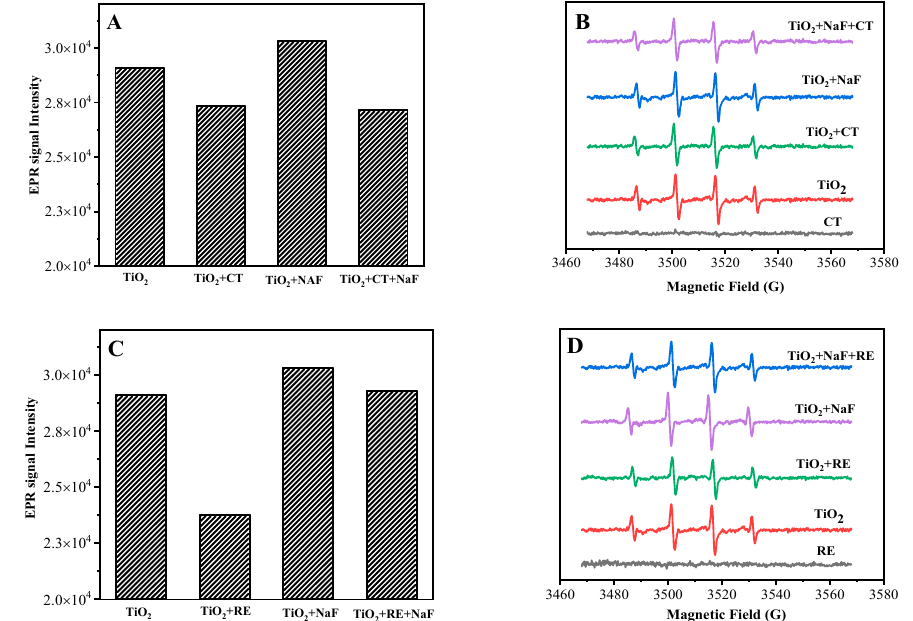
Figure 6. EPR signal intensity of hydroxyl radicals ( A , C ), and EPR signal spectra of DMPO-OH ( B , D ) in reaction systems containing CT ( A , C ) and RE ( B , D ) at 5 min of light irradiation.